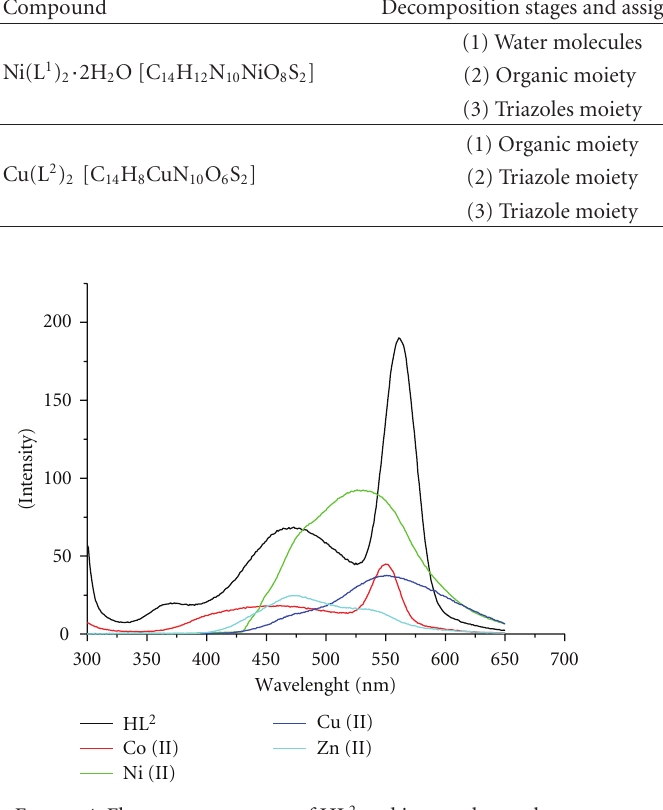
Figure 4: Fluorescence spectra of HL 2 and its metal complexes.